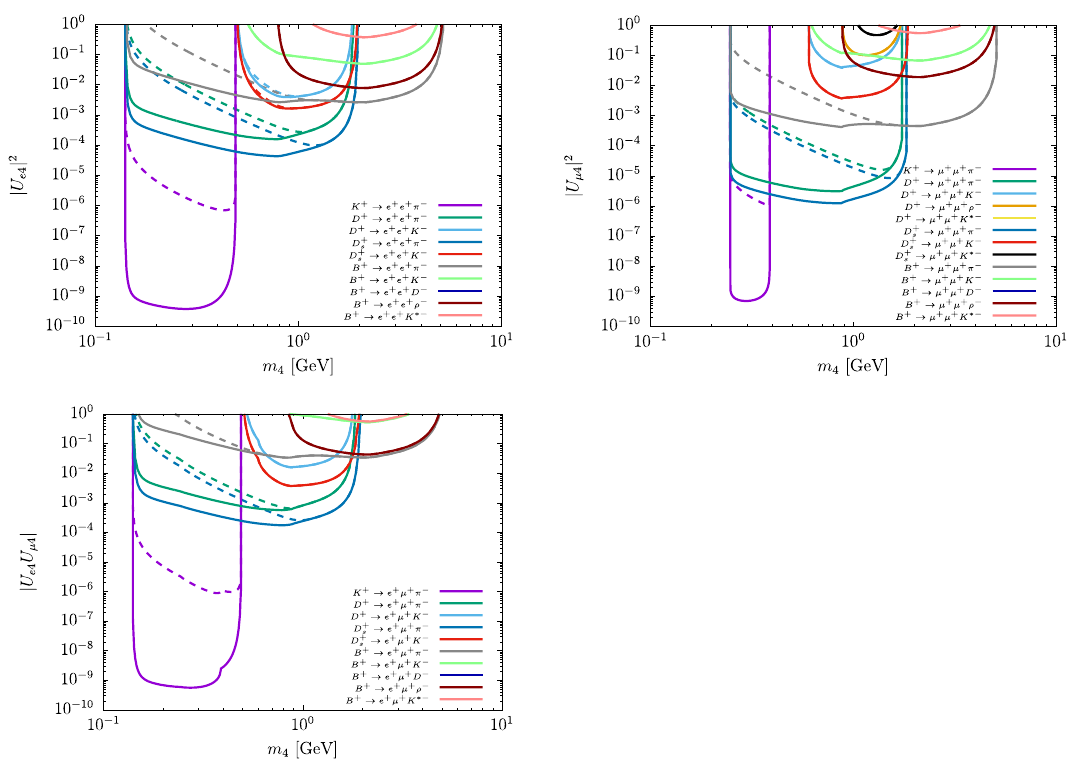
Figure 4 . Updated constraints on the relevant combination of leptonic mixing matrix elements ( j U ‘ U ‘ j ) arising from LNV pseudoscalar meson decays, as a function of the heavy sterile neutrino (cid:11) 4 (cid:12) 4 mass (GeV). Same assumptions on U ‘ as leading to (cid:12)gure 3. Dashed lines denote the bounds (cid:11) 4 . 10 m. derived under the requirement L (cid:13)ight (cid:23) 4